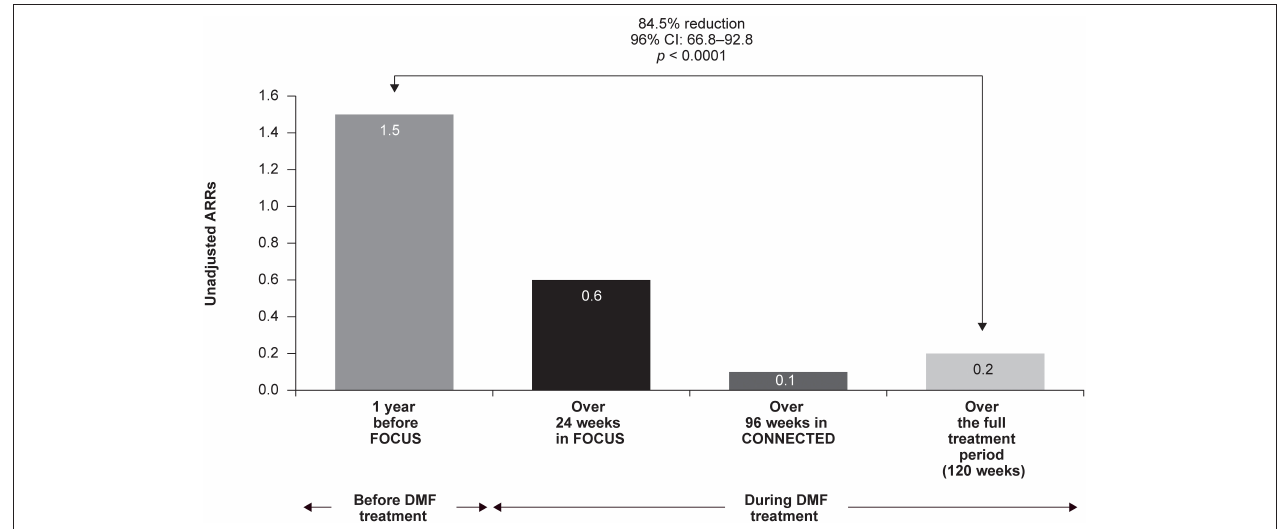
FIGURE 3 | Annualized relapse rates (ARRs) in FOCUS and CONNECTED ( N = 20). CI, confidence interval; DMF, delayed-release dimethyl fumarate.